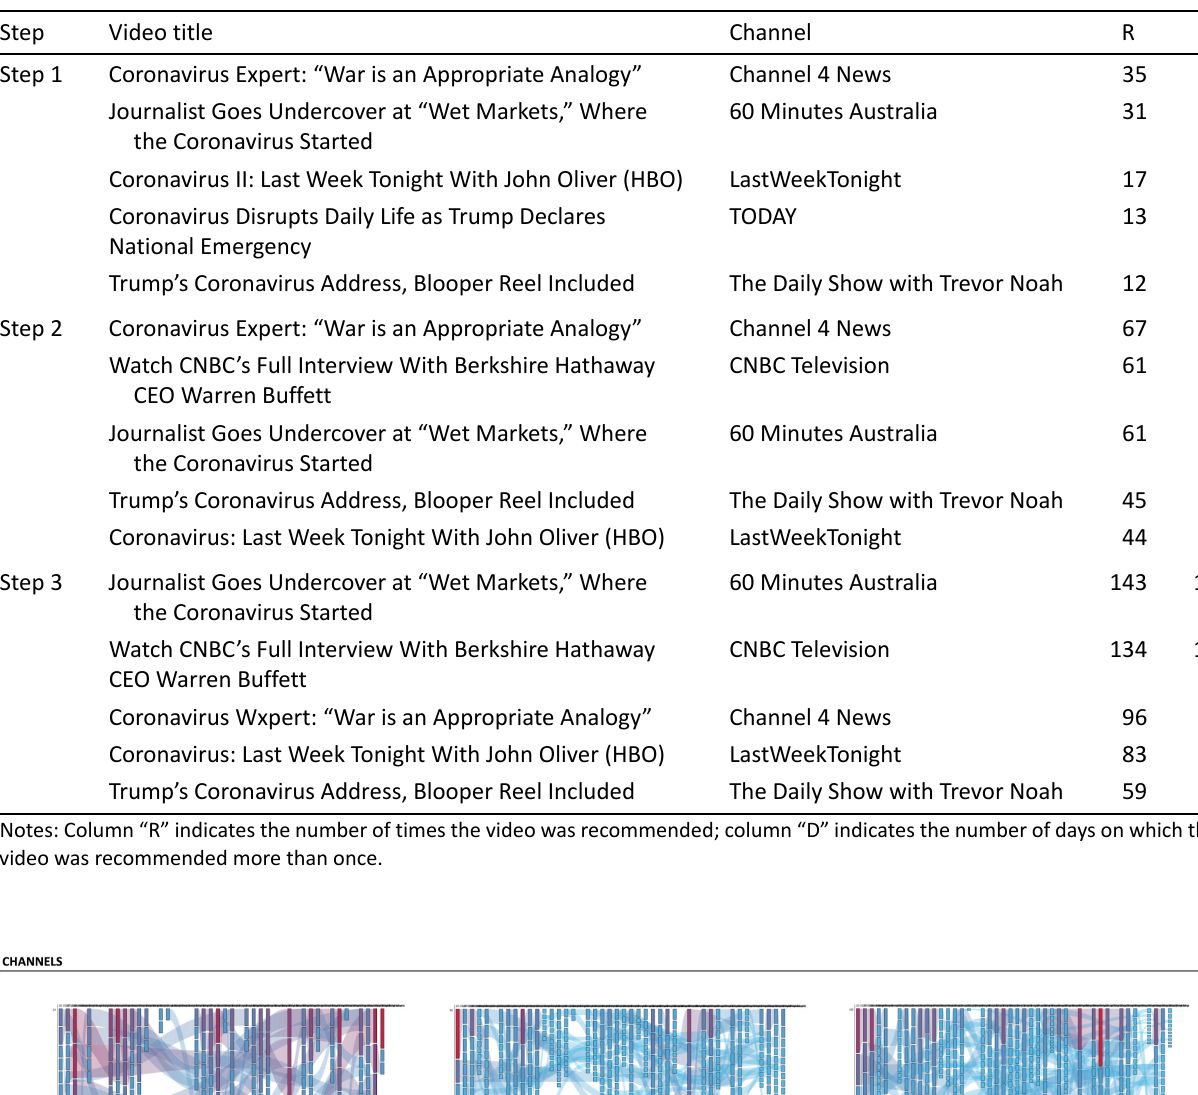
Table 2. Top five videos recommended for “coronavirus” at each step.